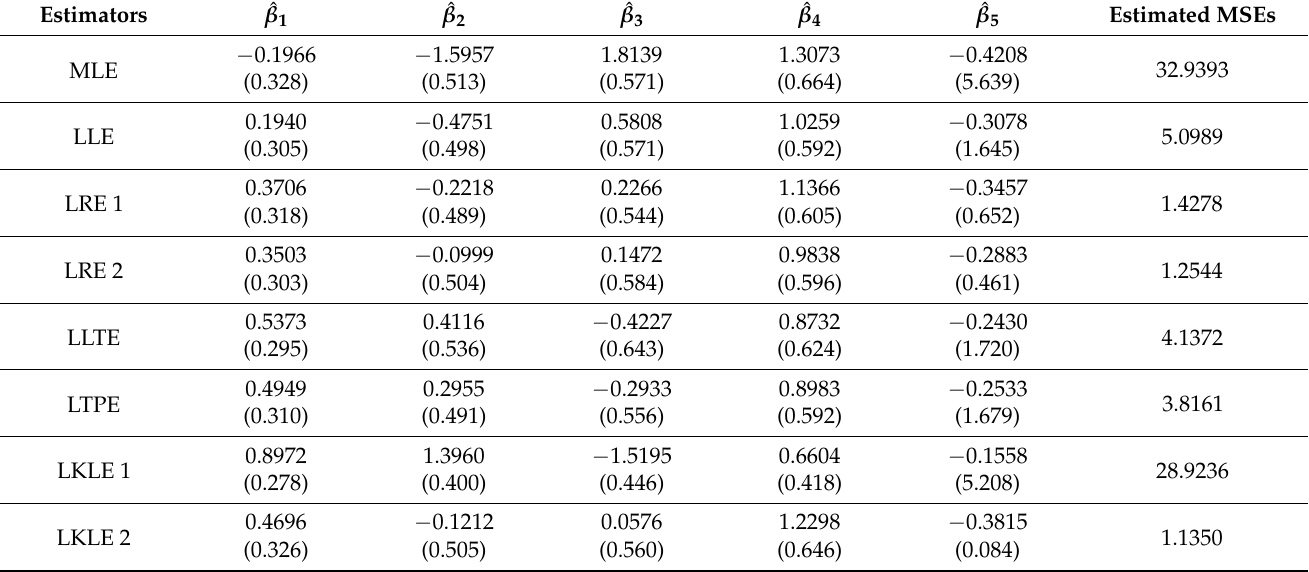
Table 6. Regression coefficients and MSEs of the logistic regression estimators for the cancer dataset